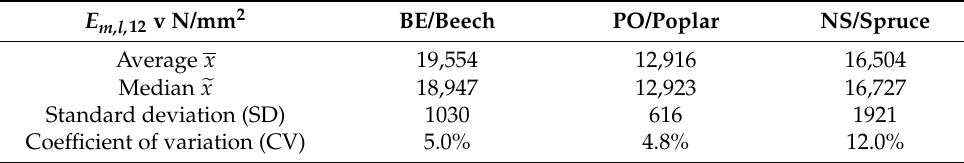
Table 4. Experimentally measured modulus of elasticity of the lamellae.